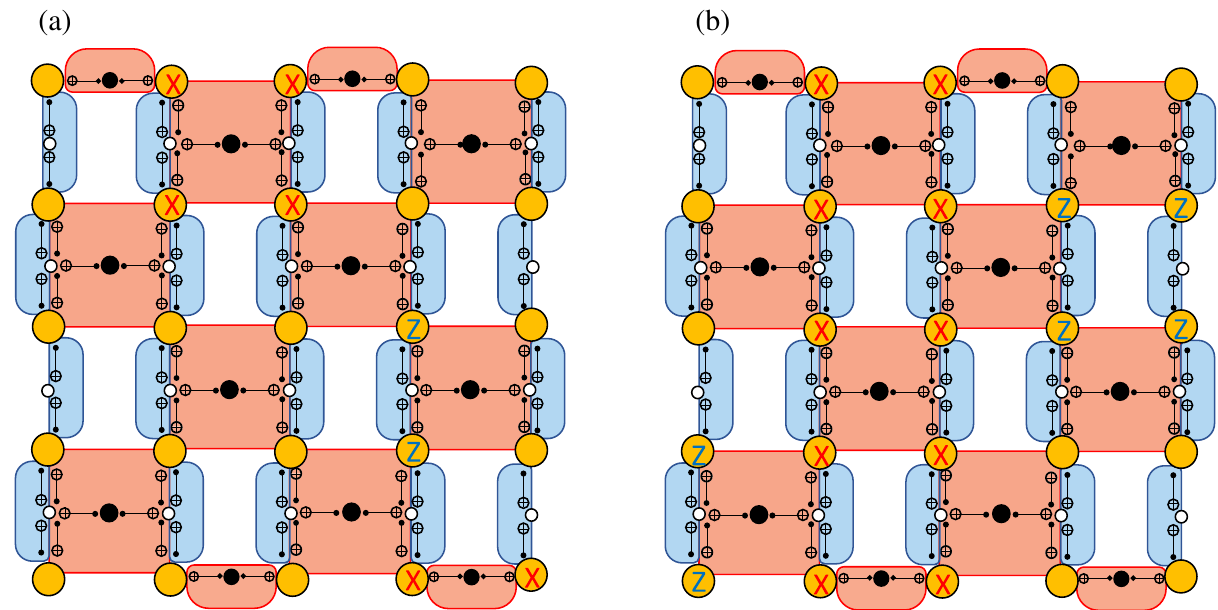
FIG. 3. (a) Gauge generators: Weight-four X -type in the bulk, weight-two X -type on the upper and lower boundaries, and weight-two Z -type. (b) Stabilizer operators: A two-column vertical strip with X -type, weight-four Z -type in the bulk, and weight-two Z -type on the left and right boundaries.